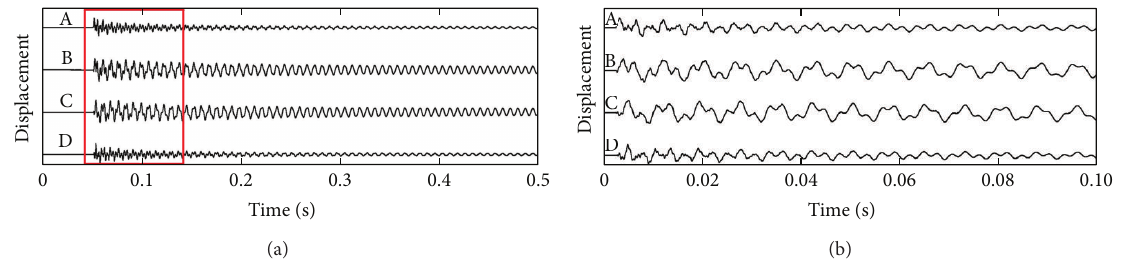
Figure 14: (a) Displacement of points A, B, C, and D in the first 0.5 sec after trigger when the excitation is at point E; (b) the displacement of 4 points in period shown in (a).